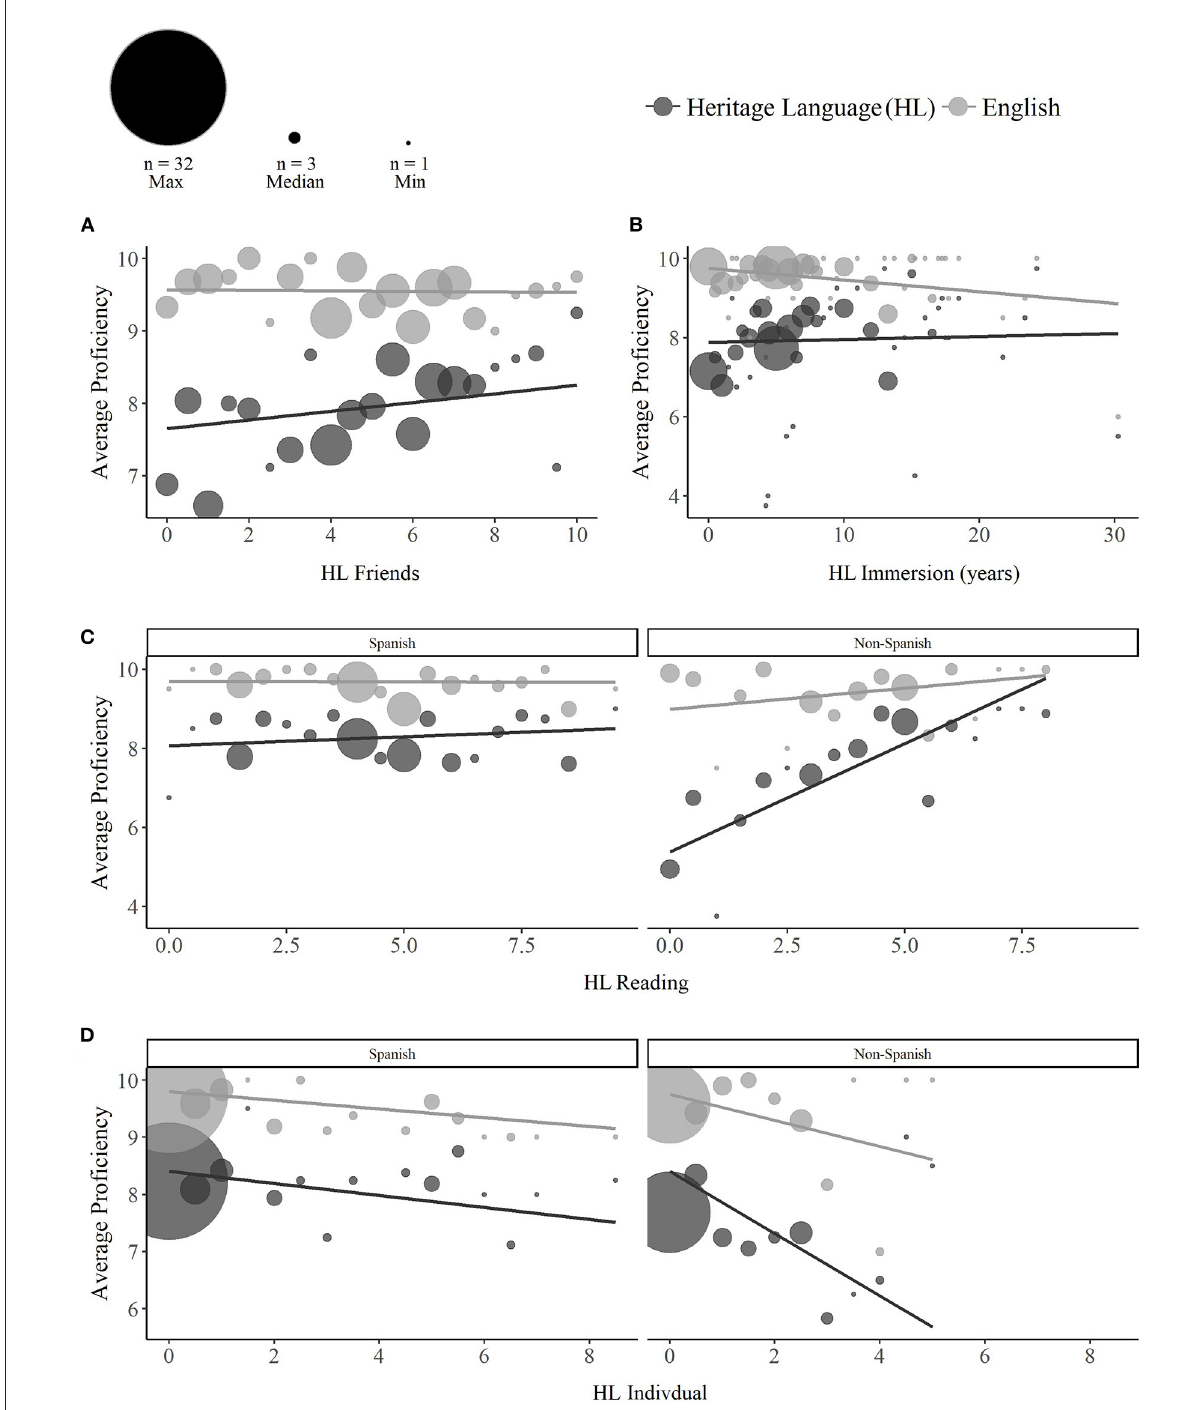
FIGURE1 Effects of heritage language (HL) experience on self-reported HL (dark gray) and English (light gray) proficiency. Across both groups, HL proficiency increased with greater HL acquisition and exposure through friends (A) , while English proficiency decreased with greater HL immersion duration (B) . HL proficiency increased with greater HL reading acquisition and exposure for non-Spanish, but not Spanish bilinguals (C) . Overall proficiency decreased with greater HL individual acquisition and exposure, which was particularly the case for HL proficiency among non-Spanish bilinguals (D) . Dot sizes reflect the number of participants contributing to each aggregated value (max = 32, median = 3, min =